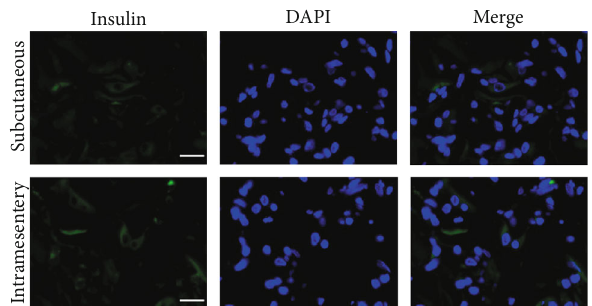
Figure 8: Immuno fl uorescence of transplanted small clusters of IPCs in diabetic mice. Small clusters of IPCs showed positive insulin staining (green) in both subcutaneous transplantation and intramesentery transplantation. Bar = 50 μ m